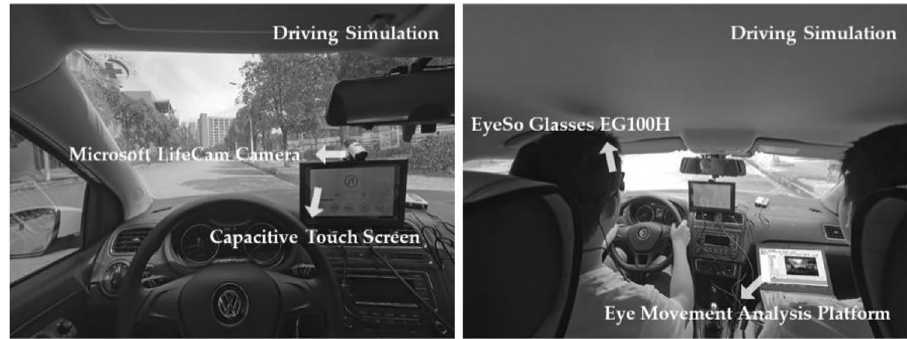
Fig. 4 The scene of driving simulation experiment